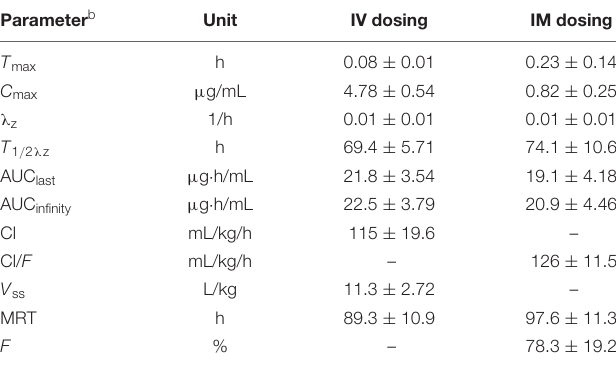
89.3 h, respectively. These were fairly long and resulted from both a large volume of distribution ( V ss ; 11.3 L/kg) and a low body clearance (Cl; 115 mL/kg/h) ( Table 1 ).